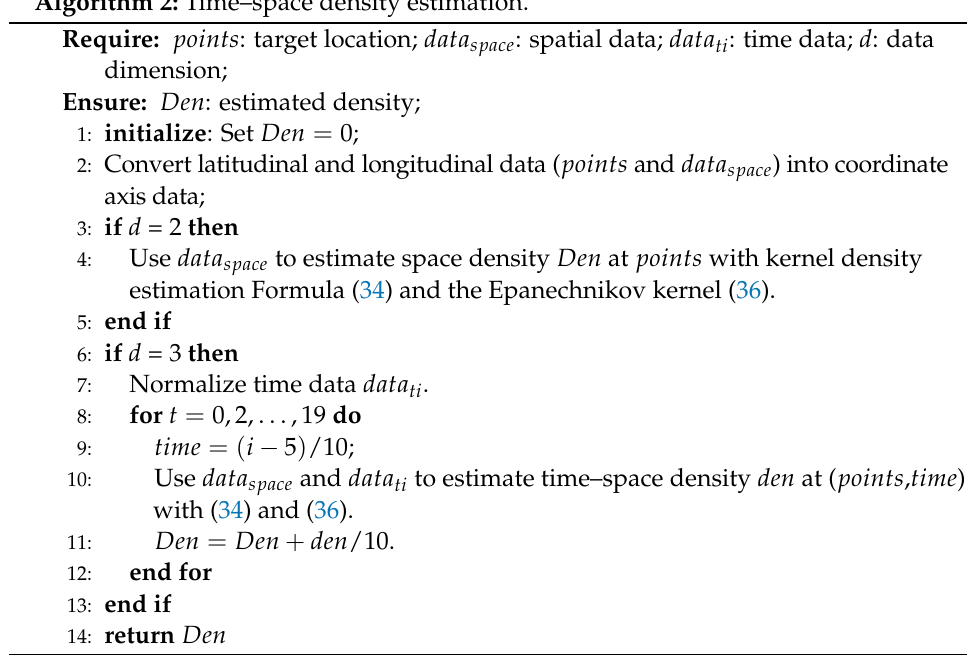
Algorithm 2: Time–space density